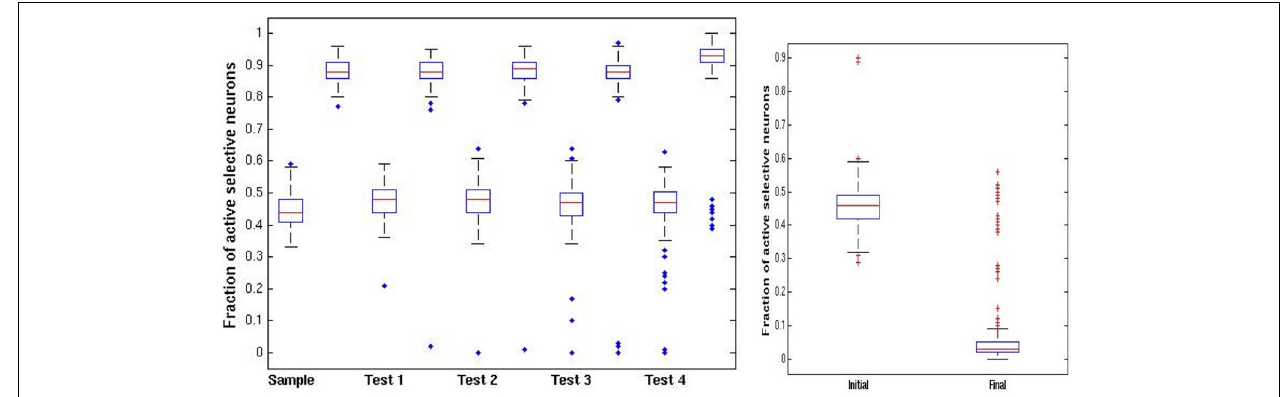
FIGURE 6 | ABBA trials. Left panel: distribution of fraction of active selective units for the sample (first) image at each stage of the trial (100 simulations). Each stage shows a pair of boxplots. The first shows the resulting activity after the network is run in the high noise regime p fire = 0 . 45. The second shows the resulting activity after the low noise regime